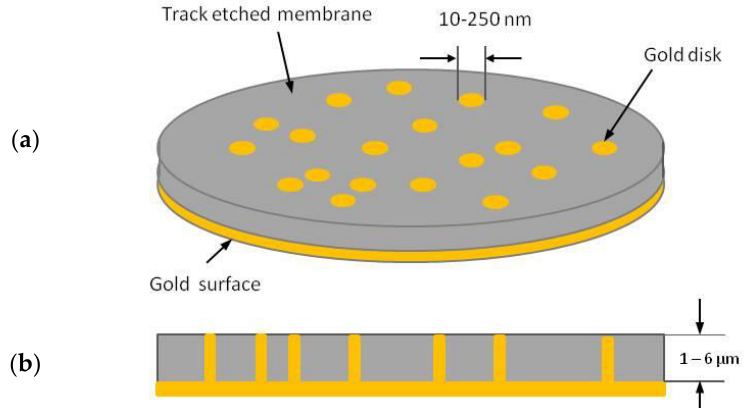
Figure 1. Schematic diagram of a nanoelectrode ensemble in a template membrane: ( a ) overall view; ( b ) cross section (redrawn and reprinted with permission from [4]).